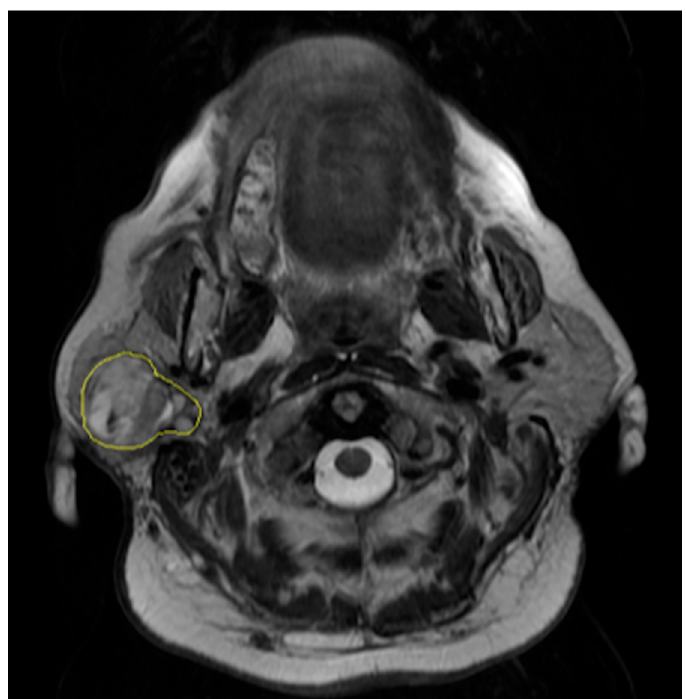
Figure 1. Segmentation of axial T2-weighted magnetic resonance (MR) image of a 61-year-old woman with a pleomorphic adenoma of the right parotid gland.